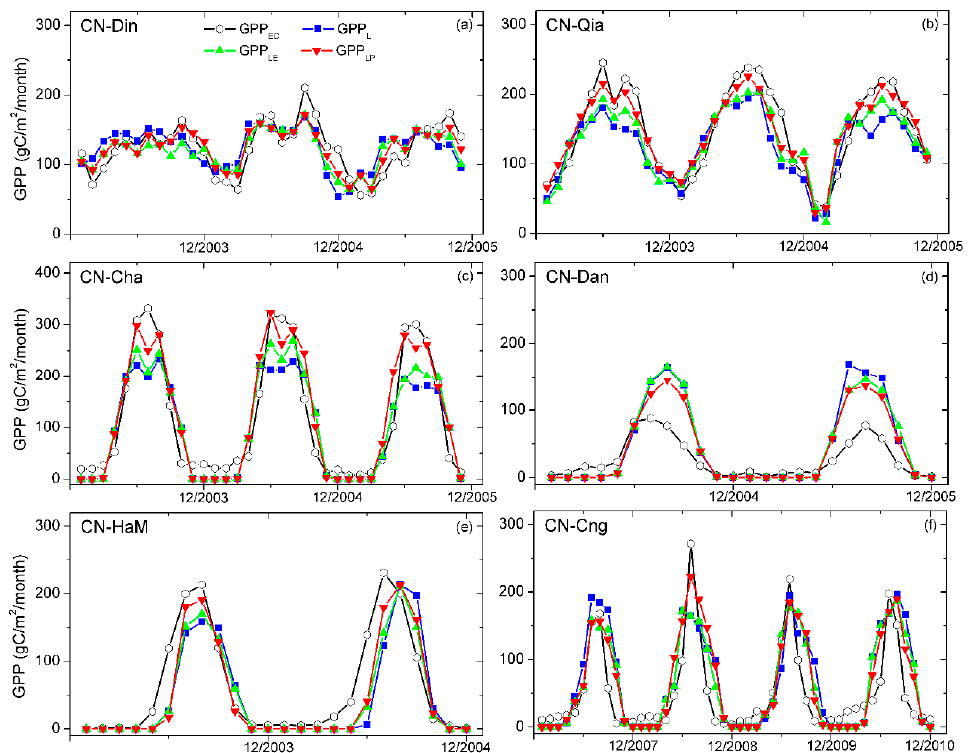
Figure 4. ( a – f ) Seasonal dynamic of tower-based and estimated gross primary productivity (GPP) from Lund-Potsdam-Jena (LPJ), LPJ-Ensemble Kalman Filter (LPJ-EnKF), and LPJ-proper orthogonal decomposition (LPJ-POD) for each site during the study period.